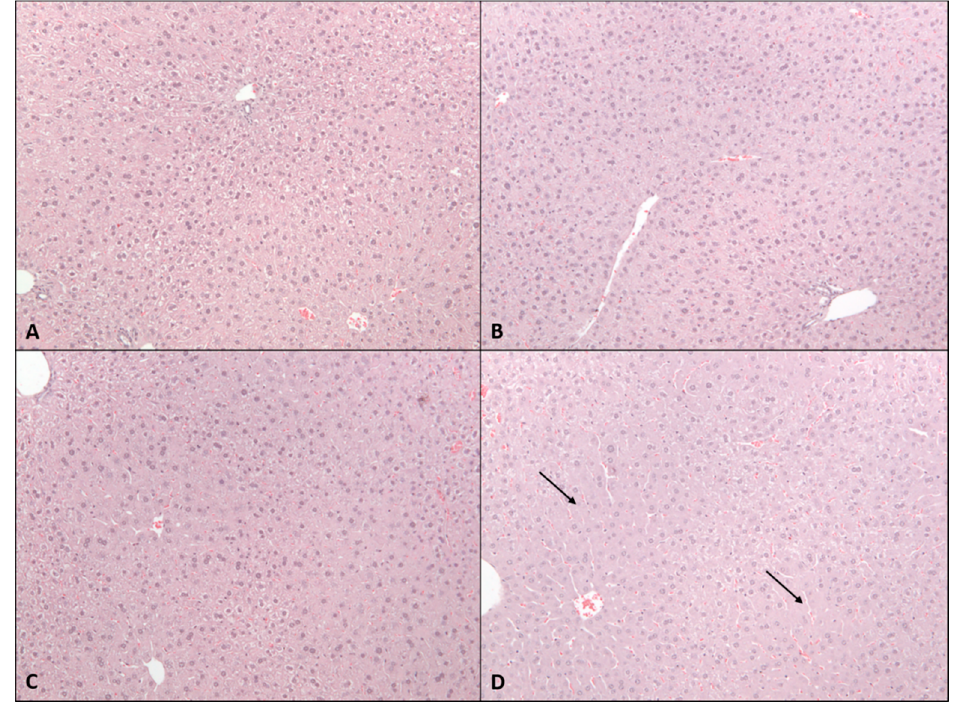
Figure 3. E ff ects of 2-week administration of CBD on liver histomorphology. H&E stained liver sections Figure 3. Effects of 2 ‐ week administration of CBD on liver histomorphology . H&E stained liver from ( A ) vehicle mice or those gavaged with ( B ) 61.5 mg / kg, ( C ) 184.5 mg / kg, or ( D ) 615 mg / kg CBD in sections from ( A ) vehicle mice or those gavaged with ( B ) 61.5 mg/kg, ( C ) 184.5 mg/kg, or ( D ) 615 sesame oil for 2 weeks. Note that 615 mg / kg group was terminated after 2–3 doses due to overt toxicity mg/kg CBD in sesame oil for 2 weeks. Note that 615 mg/kg group was terminated after 2–3 doses due elicited by to overt toxicity elicited by CBD.